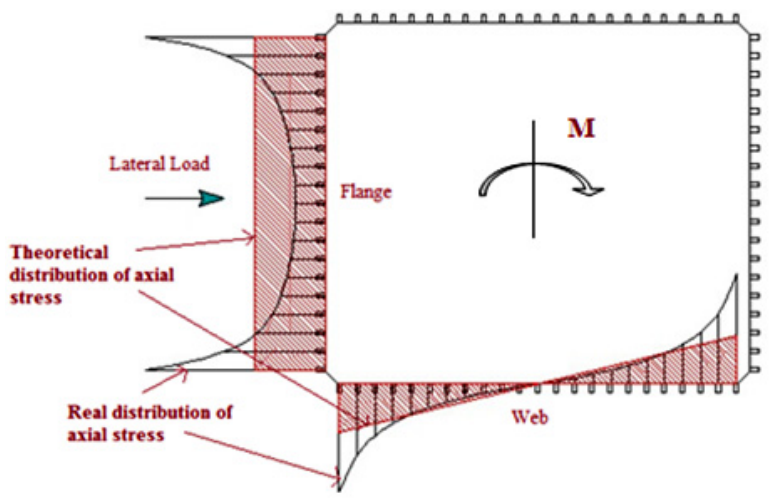
Figure 1. Axial stress distribution in the columns of the building in web as well as in flange panels.